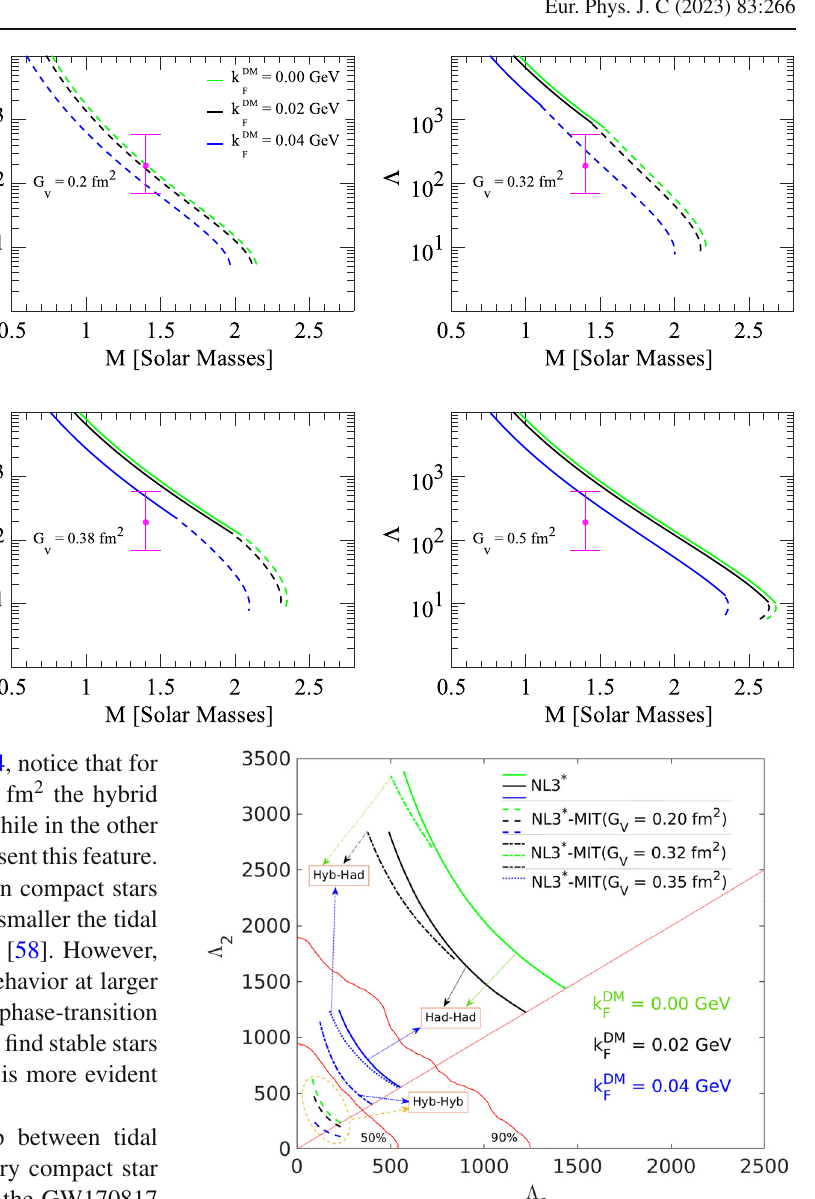
Fig. 5 Dimensionless tidal deformability parameters, (cid:16) 1 – (cid:16) 2 , for binary compact star mergers computed using the chirp mass of the GW170817 event. The diagonal red line indicates the (cid:16) 1 = (cid:16) 2 bound- ary and the other red lines denote the 50% and 90% confidence levels determined by the event GW170817. Different colors mean different values of k DM , and for each kind of line we find a value of G V (dashed F or dash-dotted lines), or pure hadronic modes (full line)